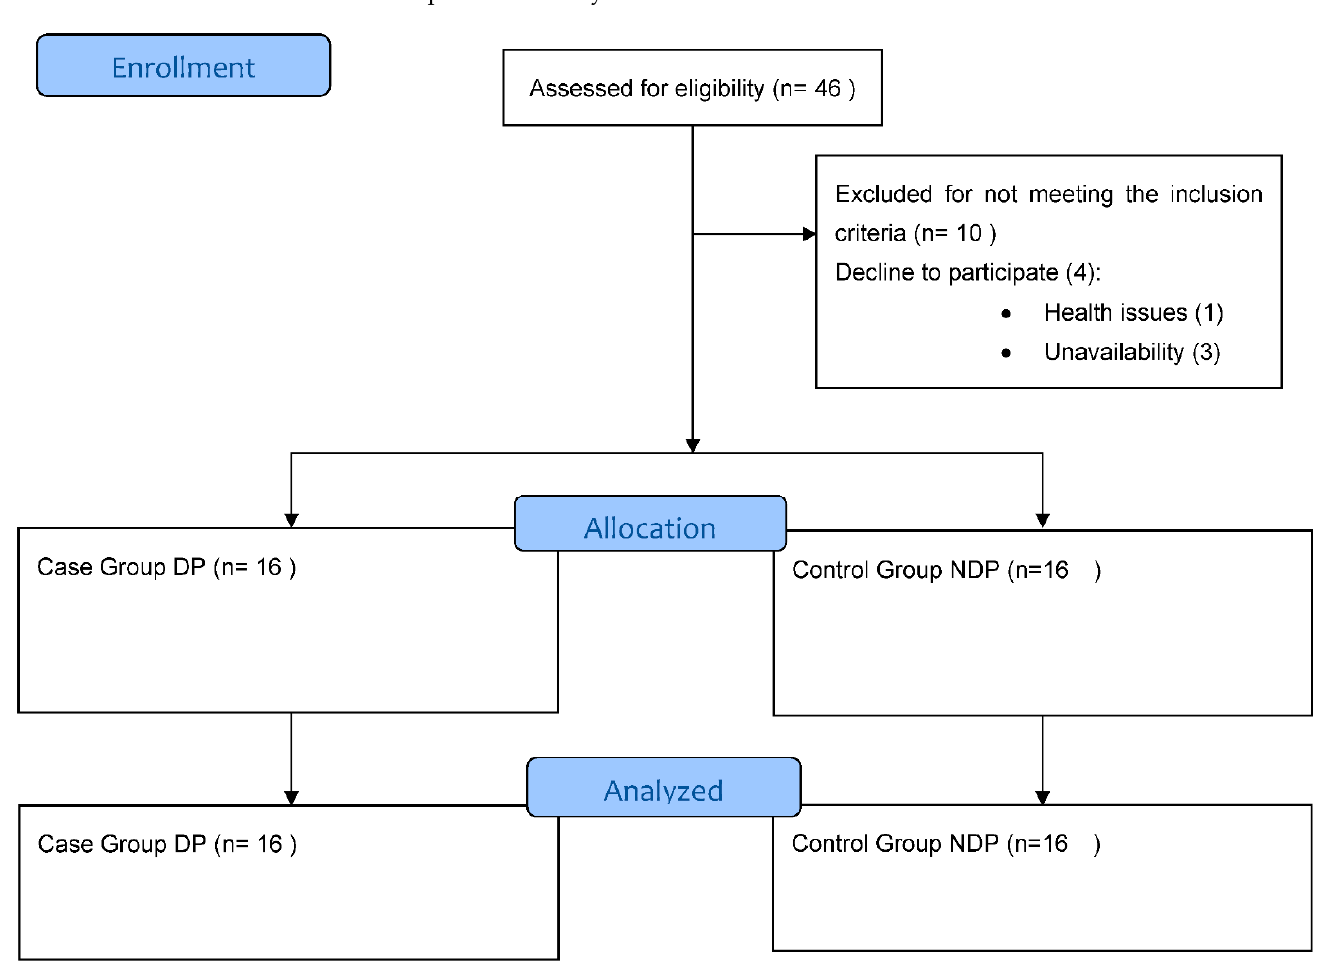
Figure 1. Flow chart.